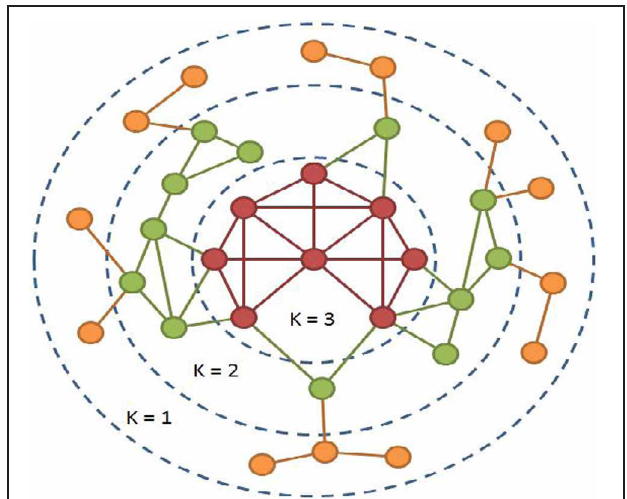
FIGURE 1 | K -core decomposition